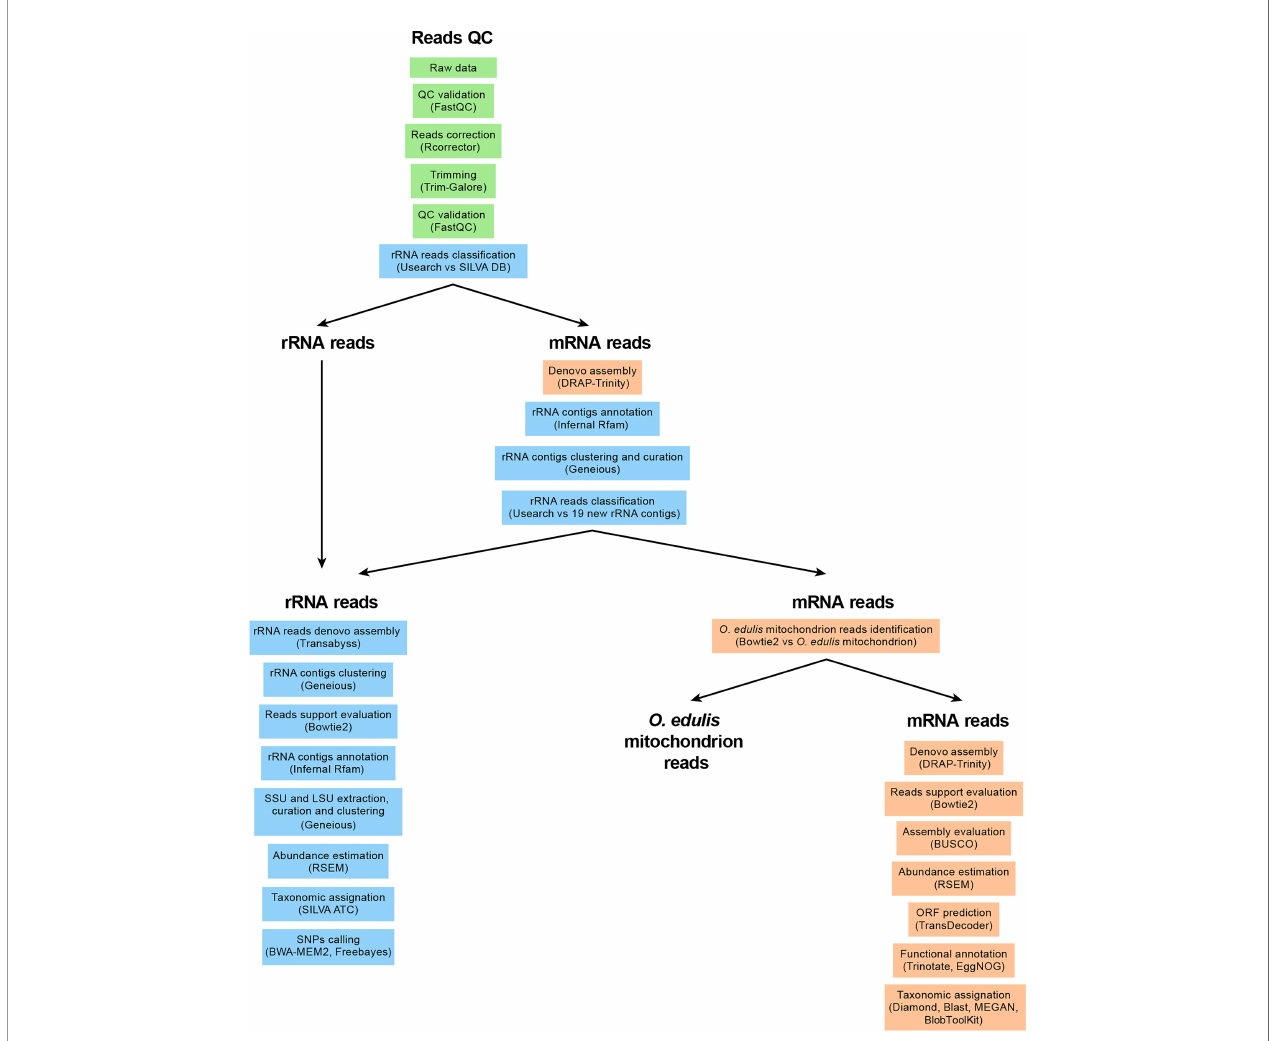
FIGURE 2 | Flowchart of the bioinformatic pipeline. First, QC reads were performed, followed by classi fi cation reads as “ ribosomal ” rRNA reads or “ coding ” mRNA reads. Finally, each read collections has been assembled and annotated separately with dedicated